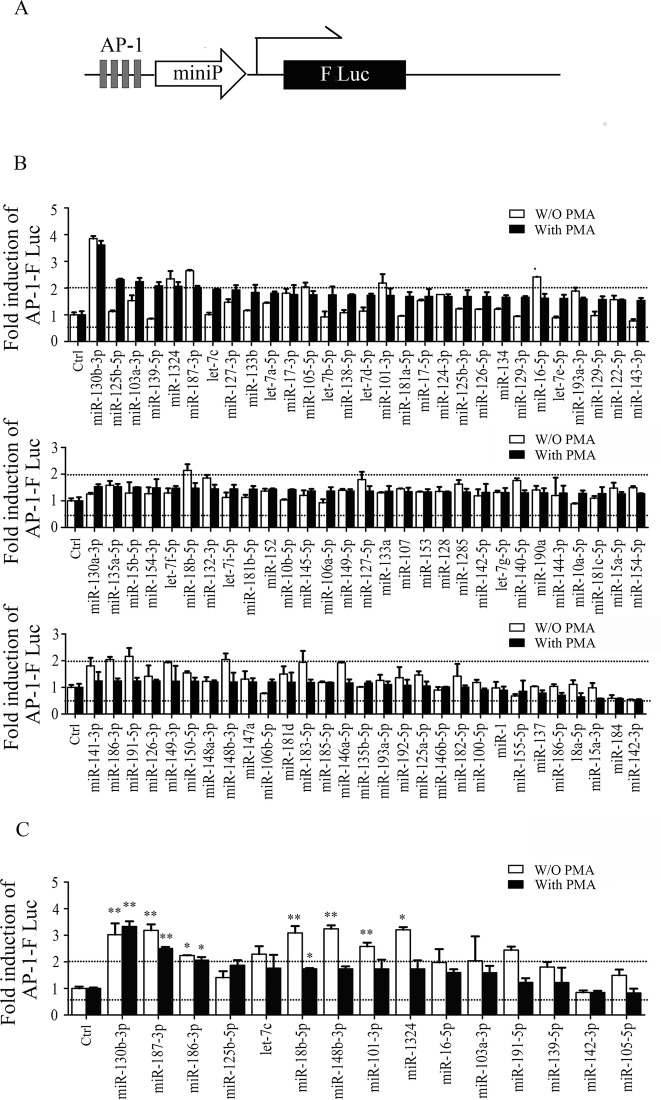
High-throughput screening for miRNAs involved in AP-1 pathway by dTuDs library and AP-1 luciferase reporter system.(A) Schematic representation of AP-1 indicator-sensor plasmid. (B-C) 293A cells were transfected with a mixture of three vectors: AP-1 luciferase reporter plasmid, RLuc plasmid and each dTuD vector. 24h after transfection, cells were treated with (black bars) or without (open bars) PMA for 18h and then harvested for luciferase activity assays. Relative activity of AP-1 were represented as the ratio of FLuc/RLuc normalized to that in cells transfected with dTuD-Ctrl. dTuDs targeting 88 miRNAs were tested for the first screen (B), and those miRNAs with a fold change > 2-fold were further verified following the same procedure as the first screen (C). The dashed lines indicate 2.0 fold above and 50% below the dTuD-Ctrl. Data were represented as the mean ± SD (n = 3). * p < 0.05, ** p < 0.01.